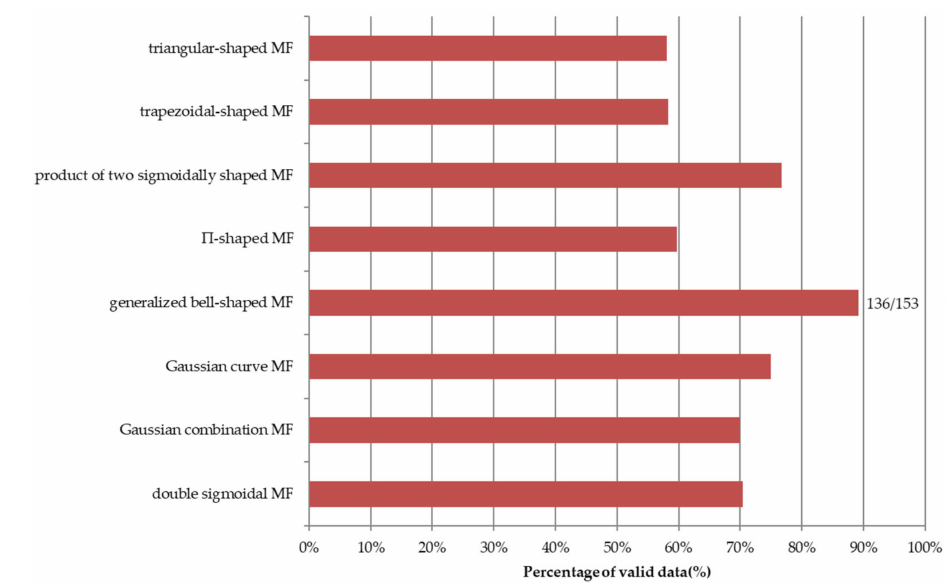
Figure 20. Percentage of valid data for each attribution